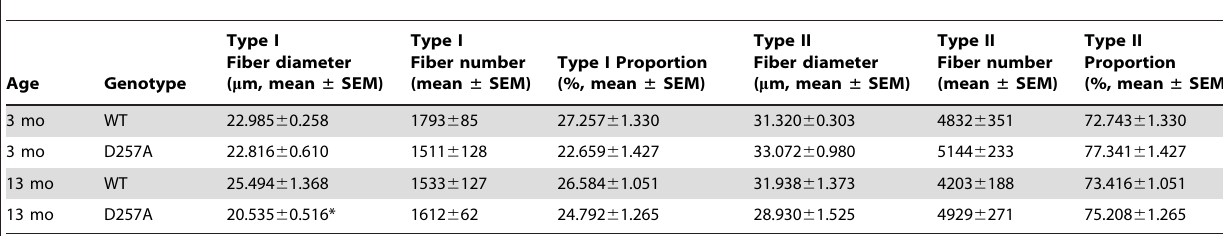
Table 1. Fiber type analysis in the gastrocnemius muscle of wild-type and D257A mice.